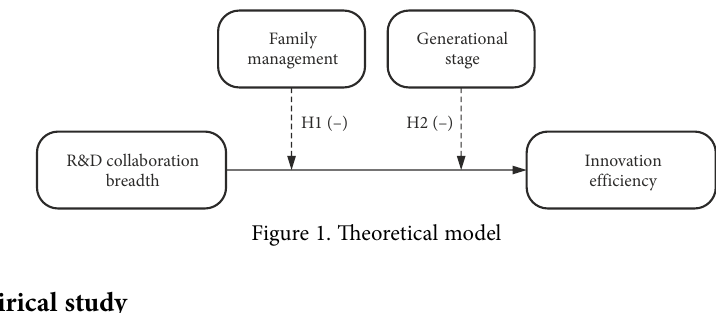
Figure 1. Theoretical